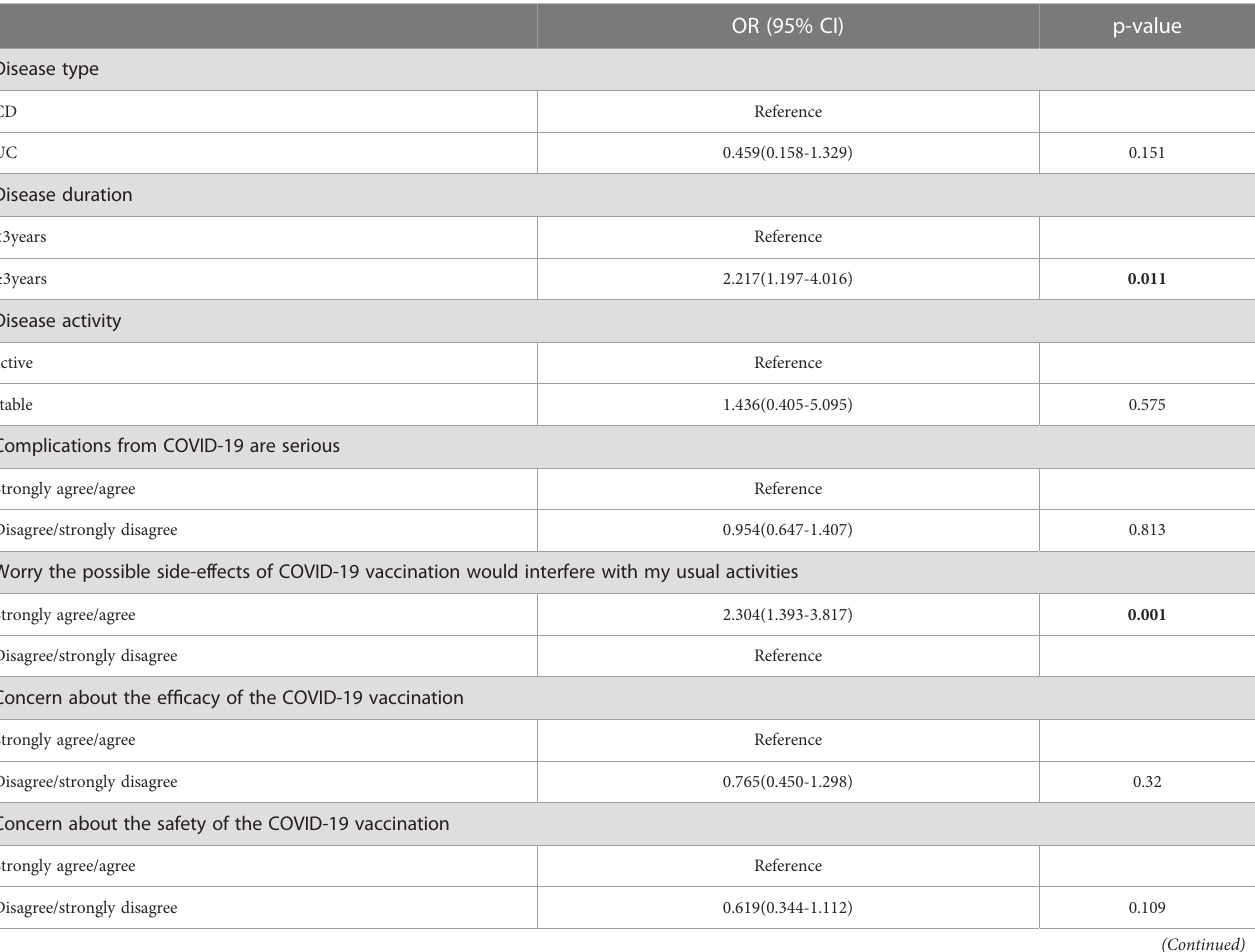
TABLE 5 Factors on intention to take the COVID-19 vaccine (multivariate analysis